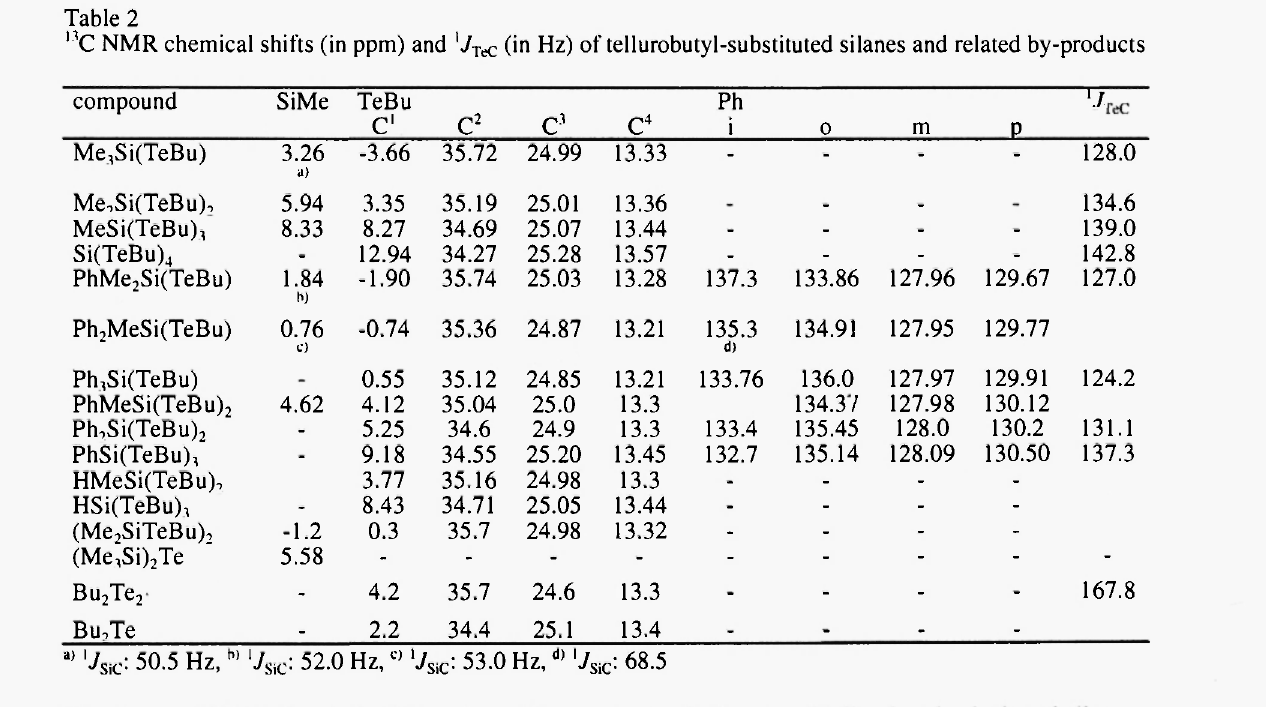
Table 2 l3 C NMR chemical shifts (in ppm); and 'y